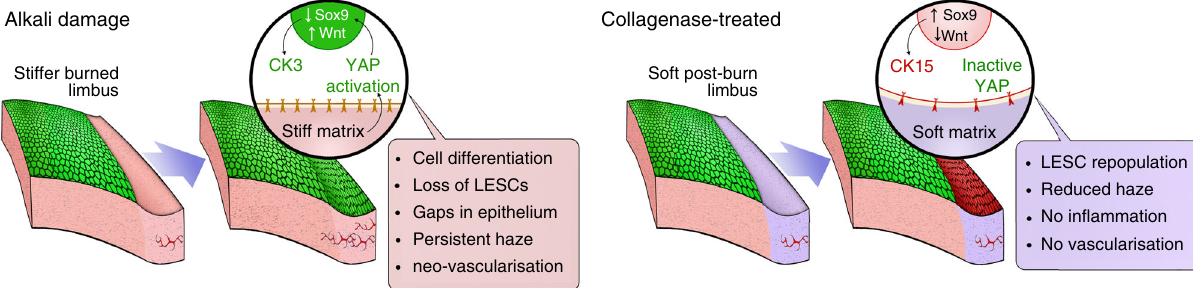
Fig. 9 Schematic representation of overall results from in vivo experiments and proposed mechanism of action. Brie fl y, stiffening of the limbus caused by alkali burn induces the activation and nuclear translocation of YAP, a key regulator of mechanotransduction. The nuclear YAP then acts as a transcription factor, promoting Wtn/ β -catenin and suppressing Sox9 signalling, which in turn induce cell differentiation and lead to loss of LESCs. By softening the burned limbus with collagenase, repopulating stem/progenitor cells retain a mostly inactive YAP, with corresponding high Sox9 and low Wtn/ β -catenin